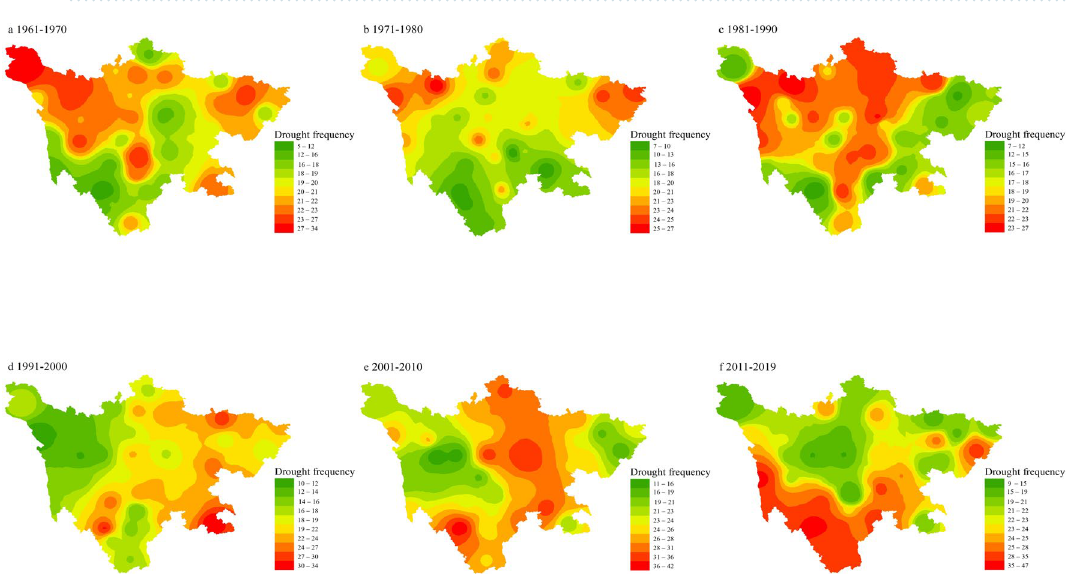
Figure 4. Base on 1-month SPEI, drought intensity during individual decades (1961–1970s, 1971–1980s, 1981–1990s, 1991–2000s, 2001–2010s, 2011–2019s) and for the full period 1960–2016 in Sichuan Province, China. (The figure was generated by ArcGIS 10.6 software, https ://deskt op.arcgi s.com/en/).